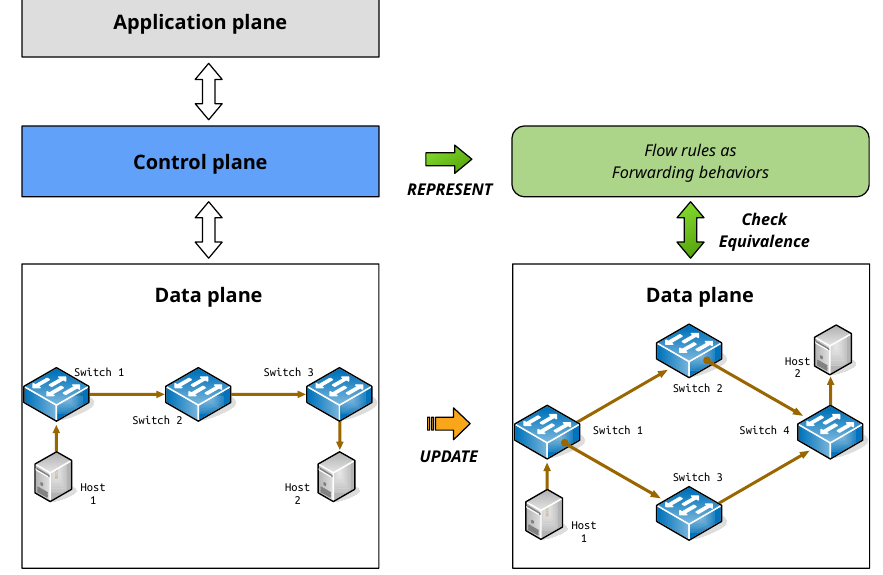
Figure 1. The overall framework of the proposed